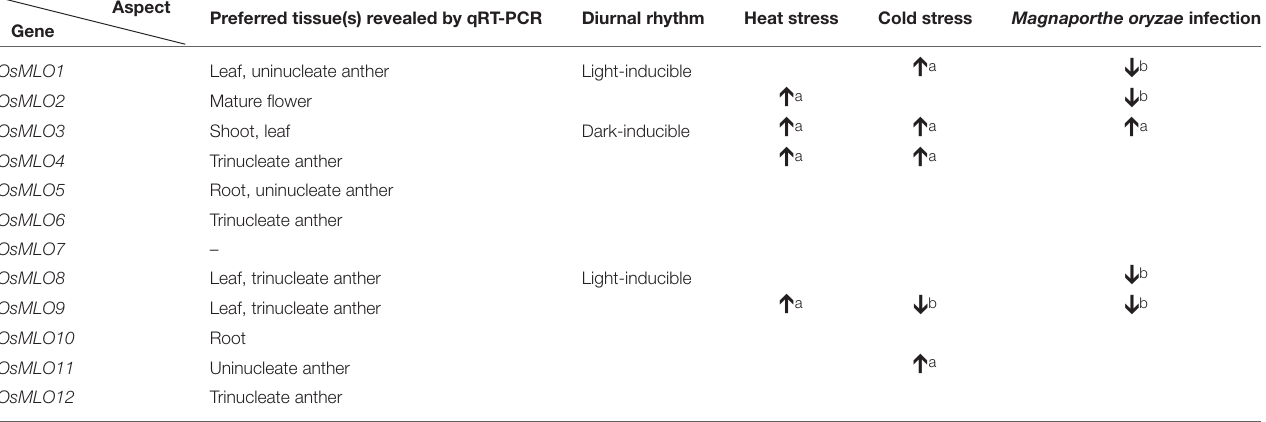
TABLE 1 | Summary of MLO family members in rice with highlighted meta-expression patterns. Gene